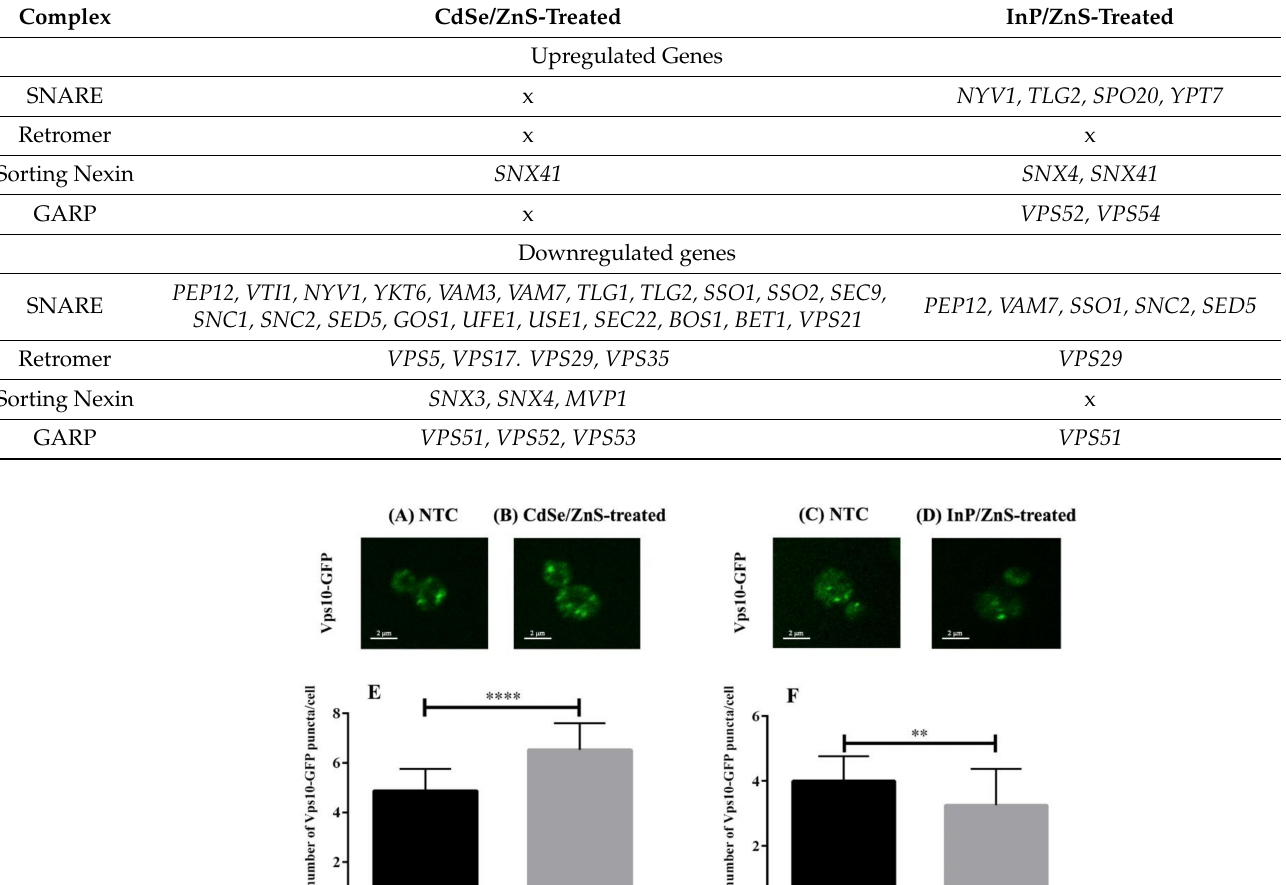
Table 2. A table that compares upregulated DEGs involved in cellular trafficking processes when exposed to green CdSe/ZnS and InP/ZnS QDs. The processes of interest include SNARE components, the Retromer, Sorting Nexin, and GARP complexes. All genes incorporated in this table had P-values of 0.05 or below.